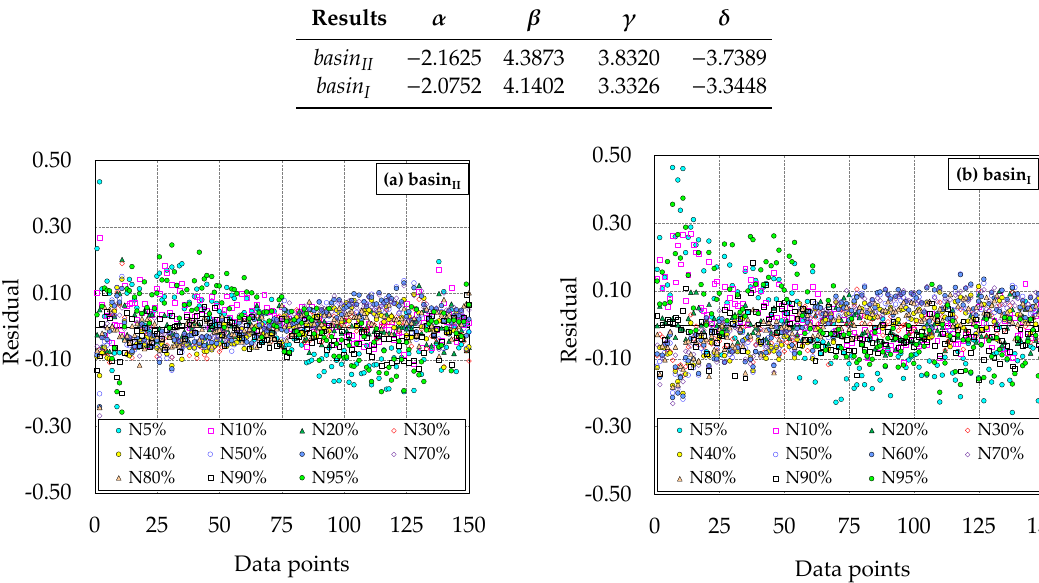
Table 6. Coefficients of Equation (5) for estimating N K% coefficient in dissipation basins. Table 6. Coe ffi cients of Equation (5) for estimating N K% coe ffi cient in dissipation basins.